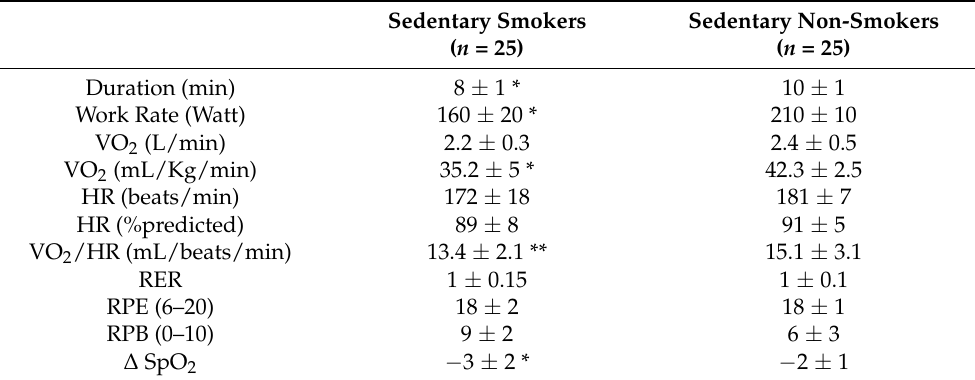
Table 3. Cardiopulmonary exercise testing parameters at maximal exercise. Sedentary